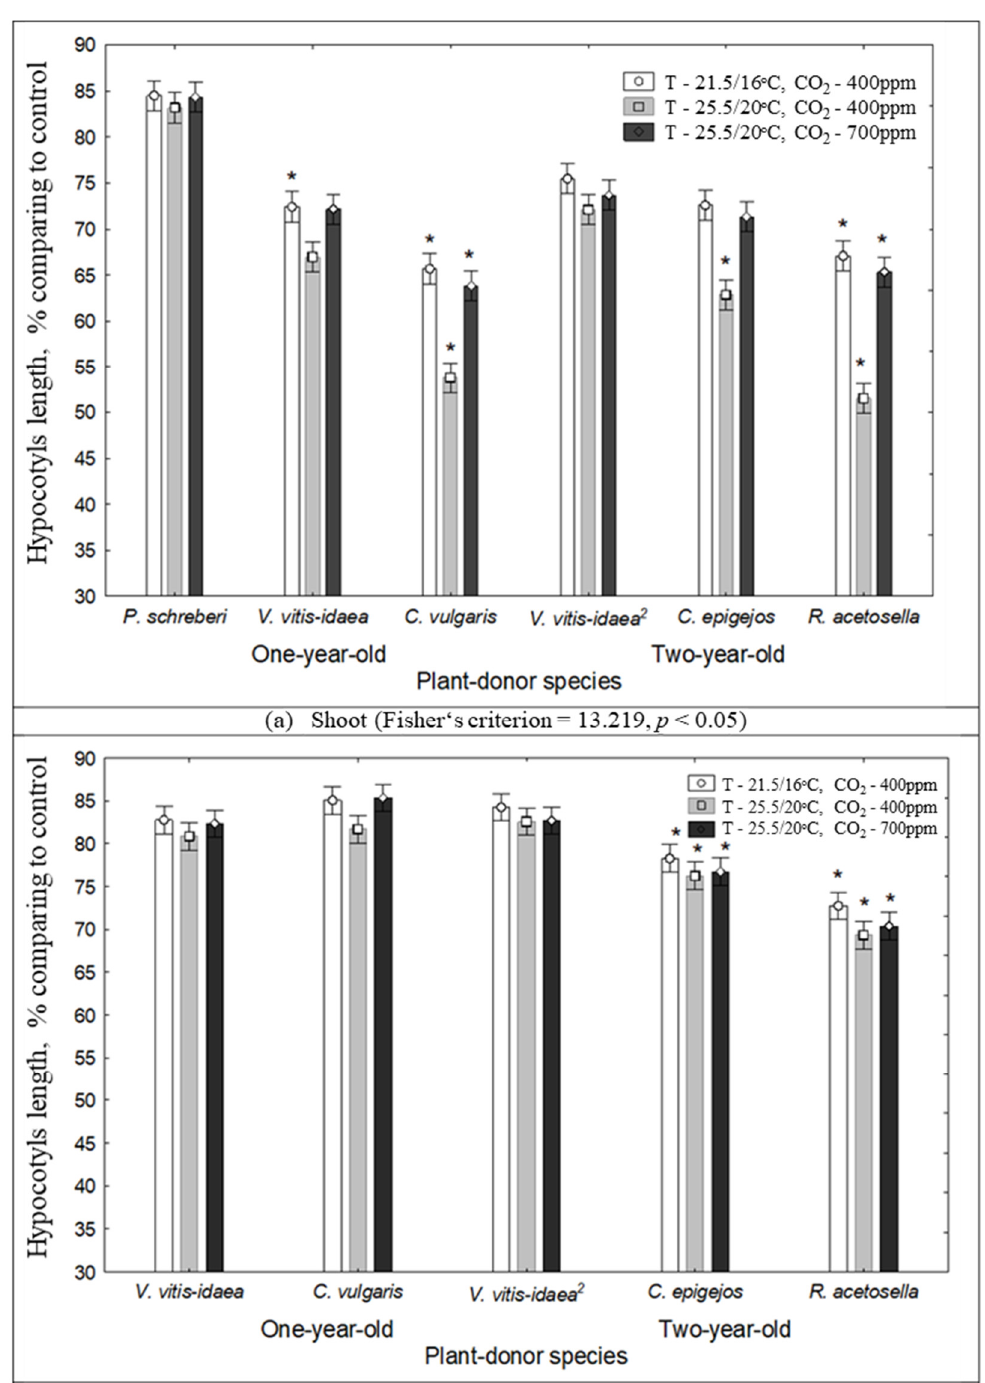
Figure 6. The impact of climate conditions on Scots pine hypocotyls length under the effect of plant-donor shoot ( a ) and root ( b ) extracts (mean ± SD, *— p < 0.05 Kruskal–Wallis test). Control conditions (21.5/16 ◦ C and 400 ppm CO 2 concentration), temperature increases of 4 ◦ C compared to the current conditions (25.5/20 ◦ C and 400 ppm CO 2 concentration), increasing temperature with higher CO 2 concentration conditions (25.5/20 ◦ C and 700 ppm CO 2 ). ( 2 )—dominant species of 2-year-old clear-cuts.